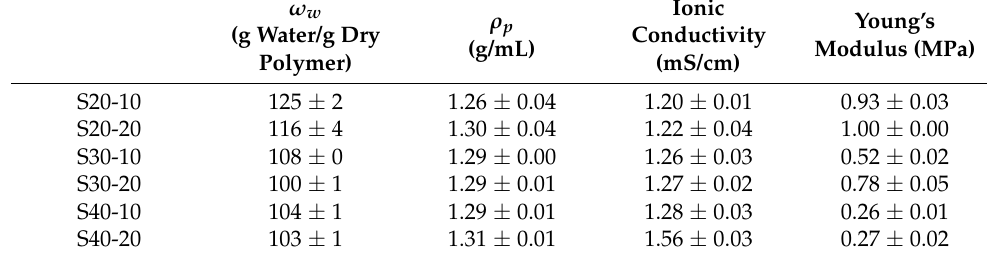
Figure 2. Representative FTIR spectra for each membrane composition.